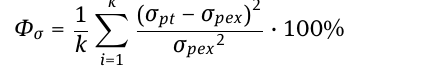
Obtained results of plastometric research were de- scribed by functions conditioning yield stresses values from strain and temperature parameters. From numerous equations allowing for detailed analysis of yield stresses four were